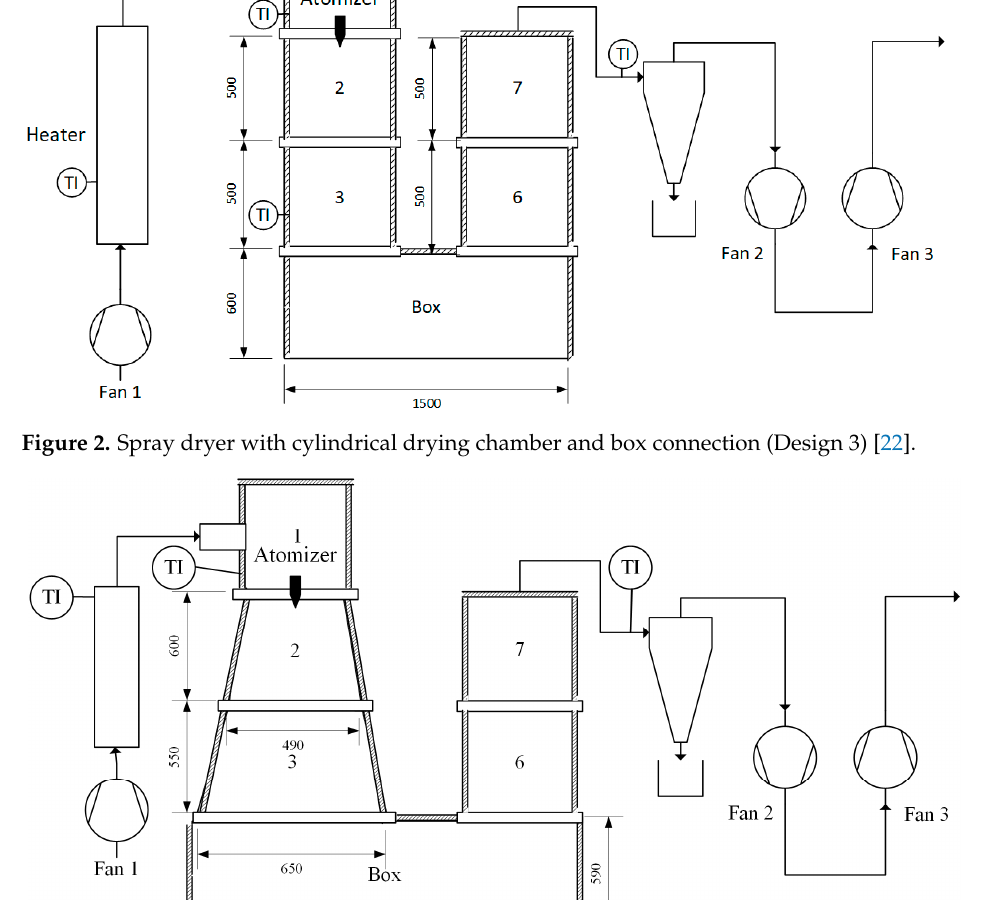
Figure 3. Spray dryer with conical drying chamber and box connection (Design 4). Table 1. Key differences between the designs and the internal volumes of the different designs .